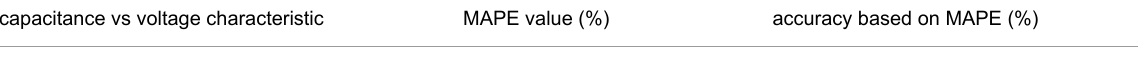
Table 2: The MAPE value of the optimized proposed single layer graphene quantum capacitance model. capacitance vs voltage characteristic